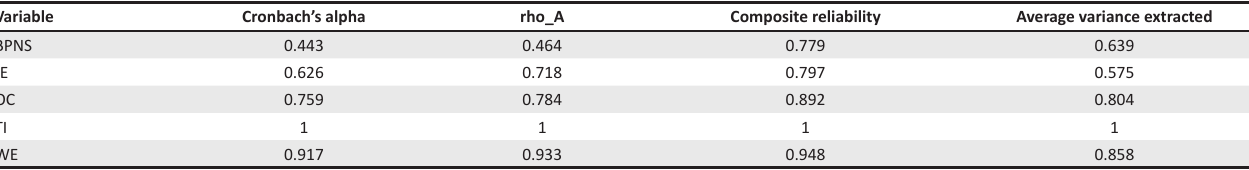
TABLE 6: Outer model (Round 2). Variable